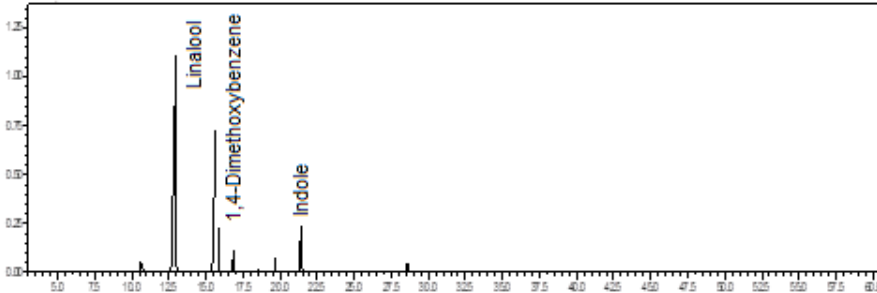
Figure 10. Ion-chromatogram of the Catasetum galeritum volatile concentrate.